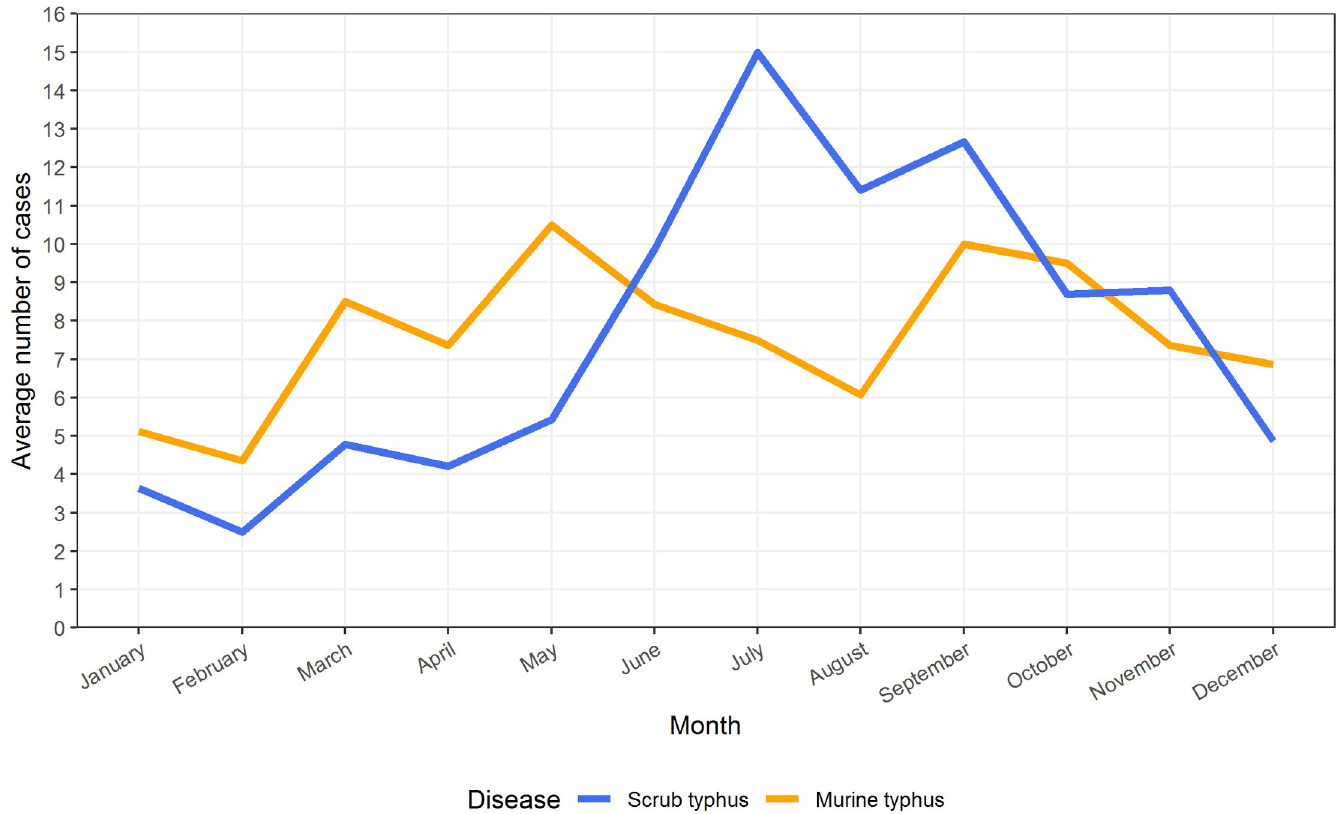
Fig 4. Mean number of patients with scrub typhus and murine typhus per month in Laos between 2004 and 2017.